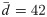
Three distinct probability distributions π(d) and simulated images.(a) Power-law distribution π(d) ∼ d−1 (S = 1) with d¯=42 (b) Exponential distribution (π(d) ∼ exp(−d/40)) (S = 0). (c) A narrow Gaussian distribution with mean d¯=40 and σd = 1 (S ≈ −1). As we go from large S (left) to small (right), the cluster of like colors become smaller, showing signs of lower color contrast.